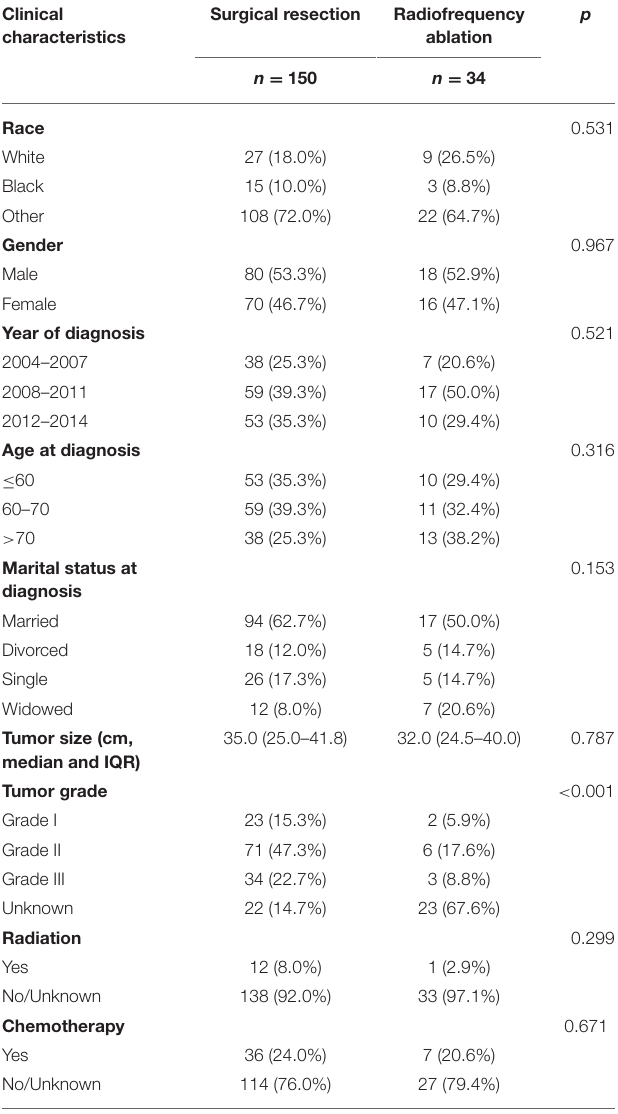
TABLE 1 | Baseline clinical characteristics for all patients. Clinical